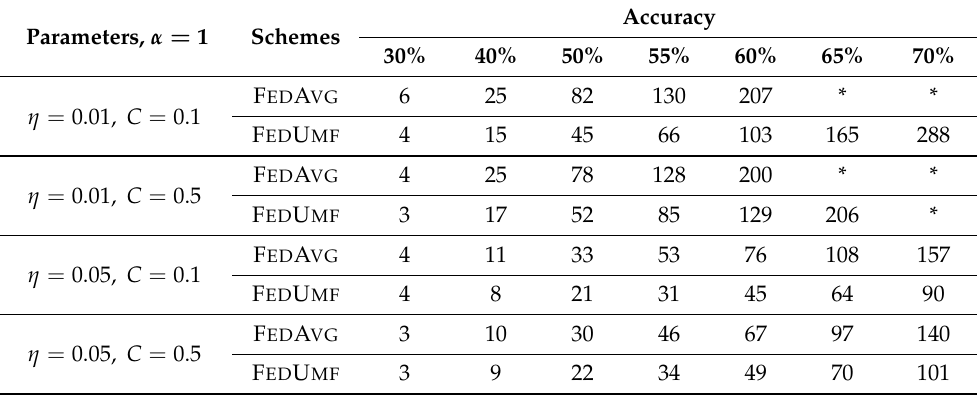
Table 3. Accuracy on CIFAR10 dataset, IID partition.